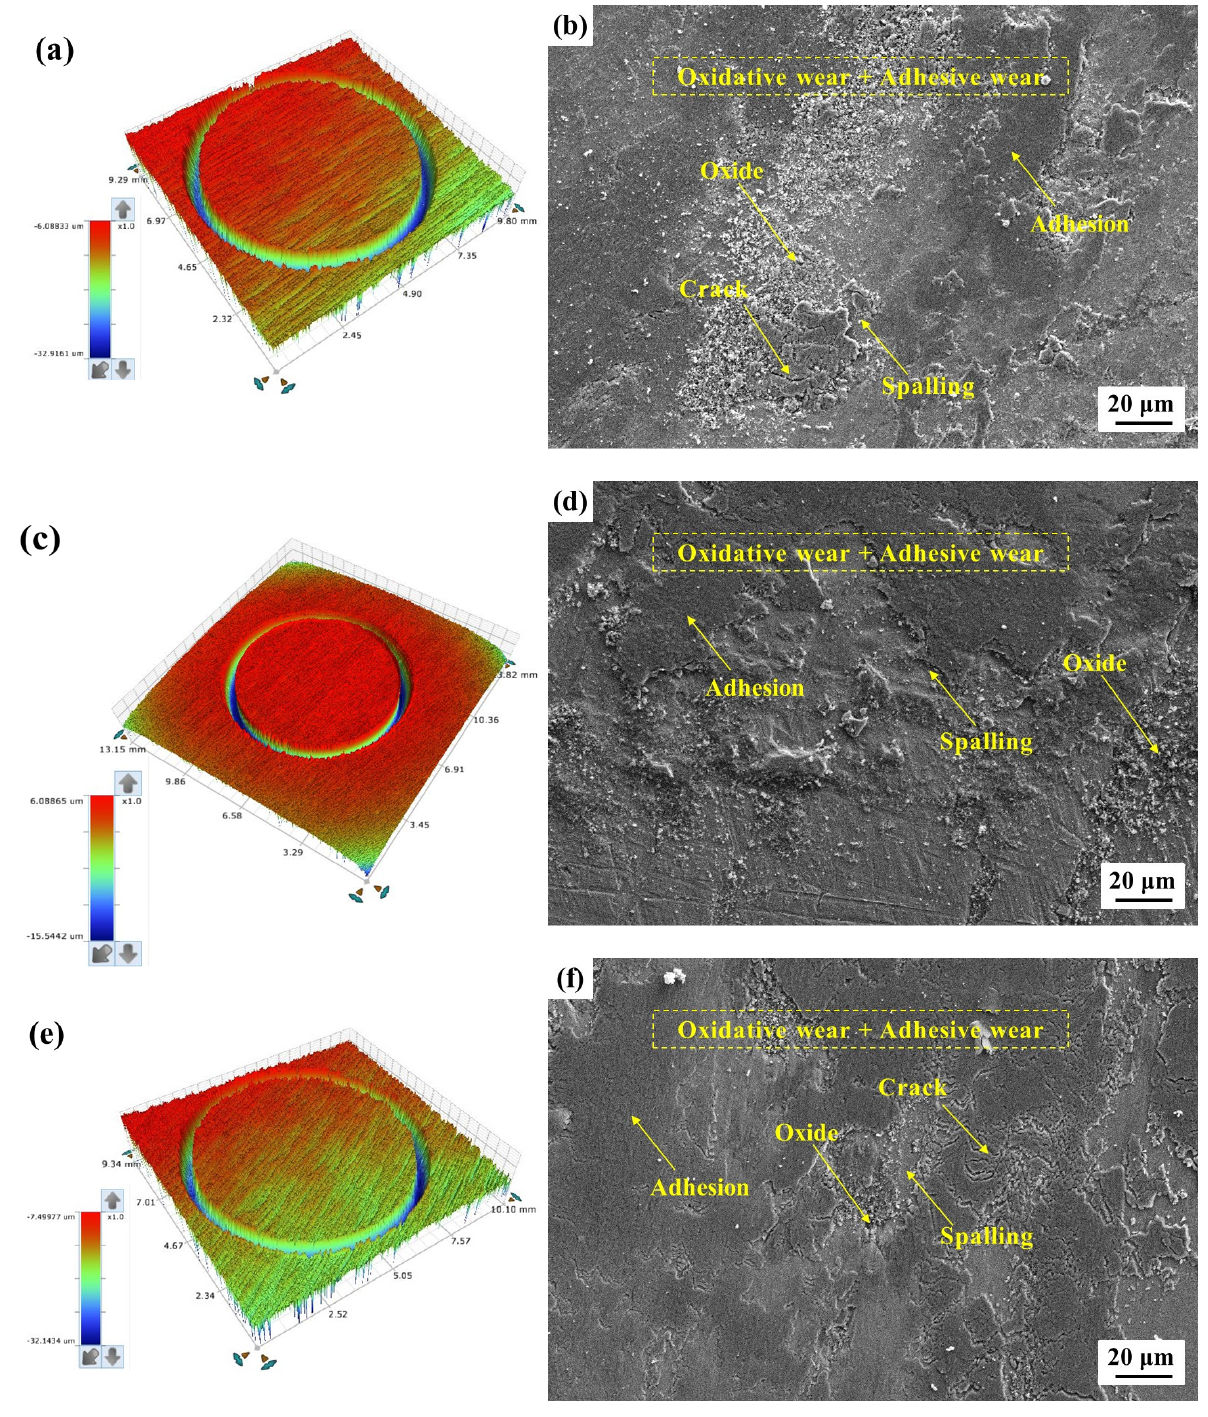
Figure 8. The 3D profile and the SEM images of wear morphology on the wear surface under a normal load of 70 N: ( a , b ) SKD11; ( c , d ) DC53; ( e , f ) SLD-MAGIC.